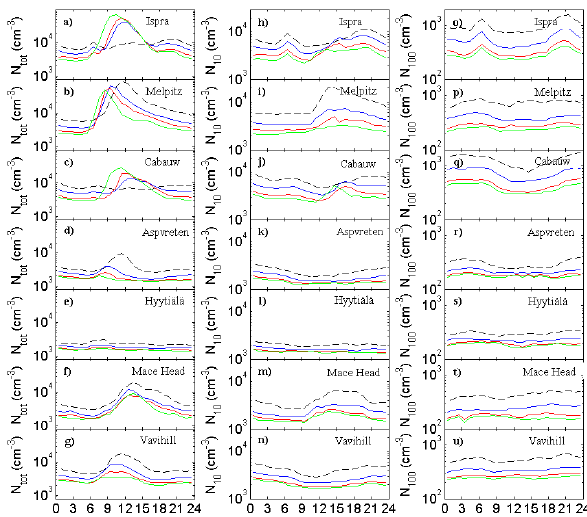
Fig. 4. Median diurnal cycles for N tot (a–g) , N 10 (h–n) , and N 100 Fig. 4: Median diurnal cycles for N tot (a-g), N 10 (h-n), and N 100 (o-u) for May 2008 (black 1009 dashed lines), the baseline 2030 scenario (blue lines), the MTFR 2030 scenario (red lines), 1010 (o–u) for May 2008 (black dashed lines), the baseline 2030 scenario and the MCE 2030 scenario (green lines). 1011 (blue lines), the MTFR 2030 scenario (red lines), and the MCE 2030 scenario (green lines).